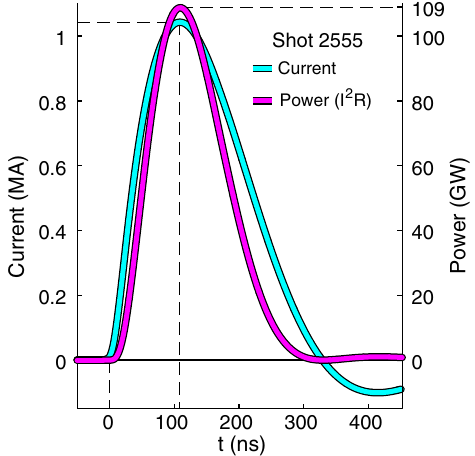
FIG. 9. Sample plot of output current and power from the 100- GW LTD